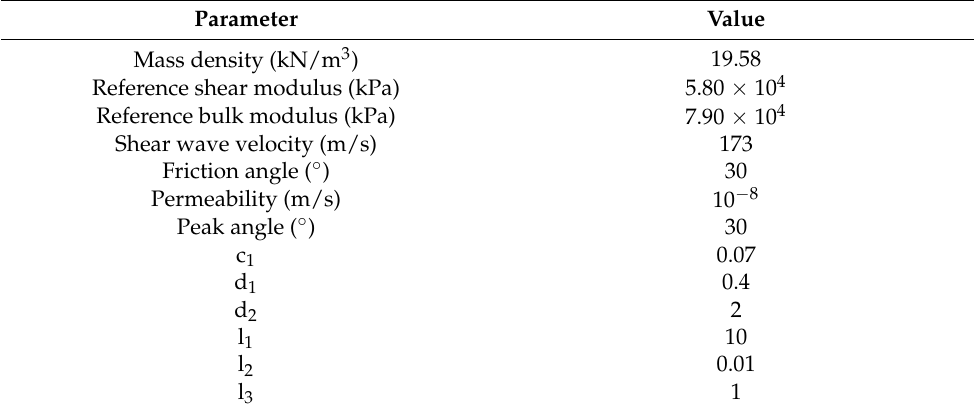
Table 2. 20 m soil parameters.